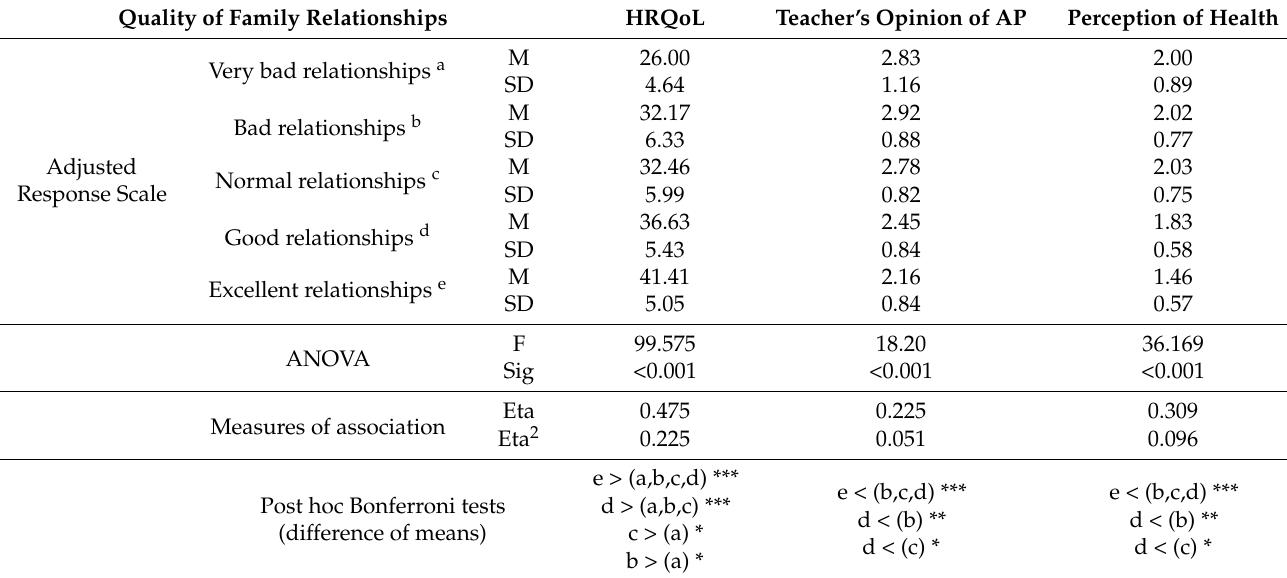
Table 1. Descriptive data and ANOVA analysis of HRQoL, teacher’s opinion of school performance and perception of health status according to family relationships. Quality of Family Relationships